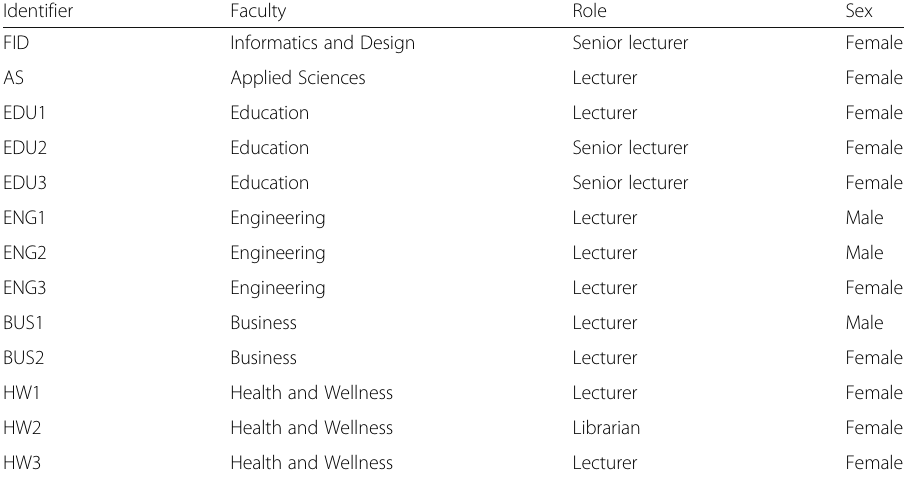
Table 1 Participants of this study (champions only)